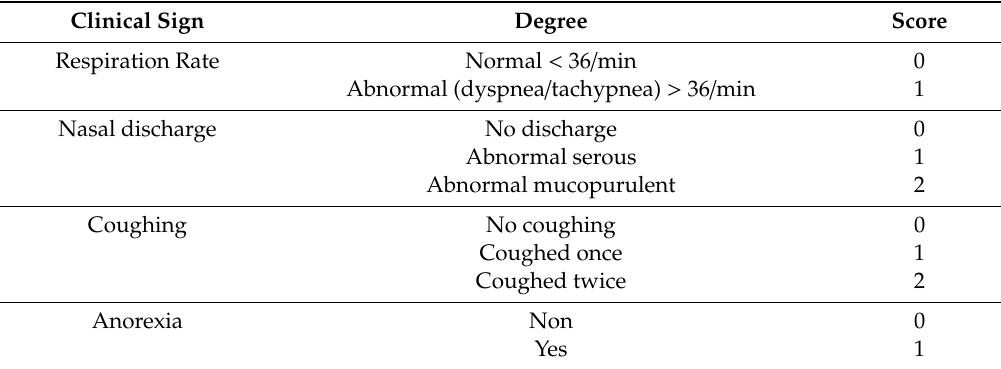
Table 1. Clinical signs scoring